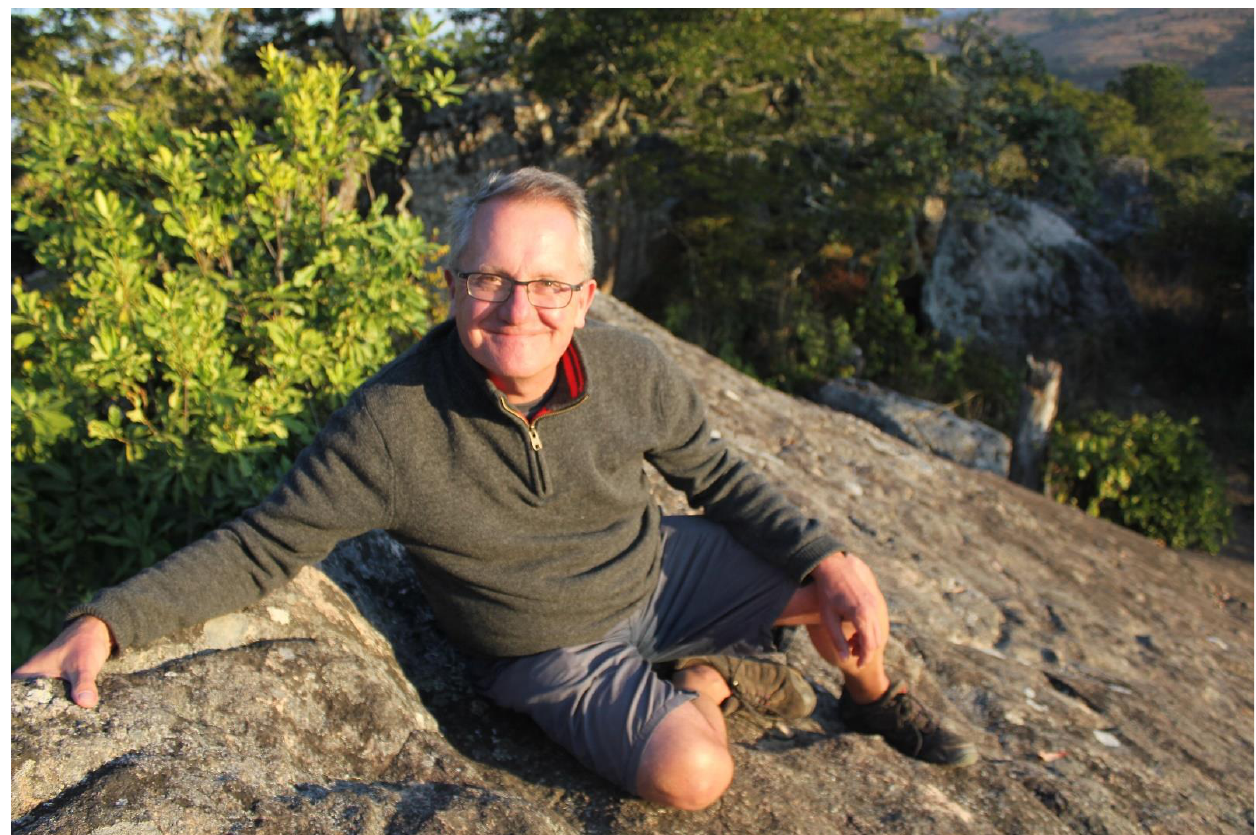
Figure 1. Photo of Professor David (Dave) Mark